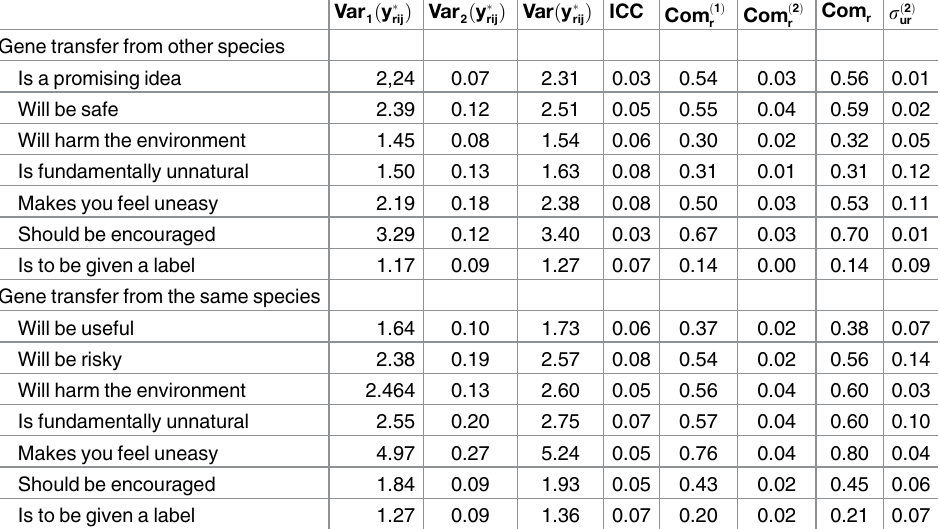
Table 6. Institutional influence explained by different